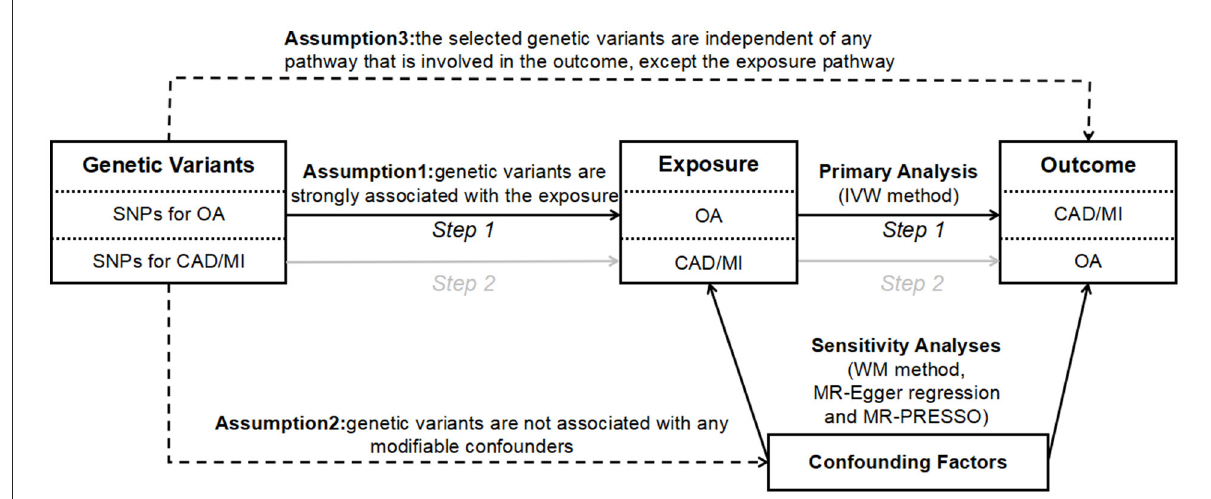
FIGURE1 The design of bidirectional MR study. The solid paths are significant; dashed paths should not exist in the MR study. SNP, single nucleotide polymorphism; CAD, coronary artery disease; MI, myocardial infarction; OA, osteoarthritis; IVW, inverse variance weighted; WM, weighted median; MR-PRESSO, Mendelian randomization pleiotropy residual sum and